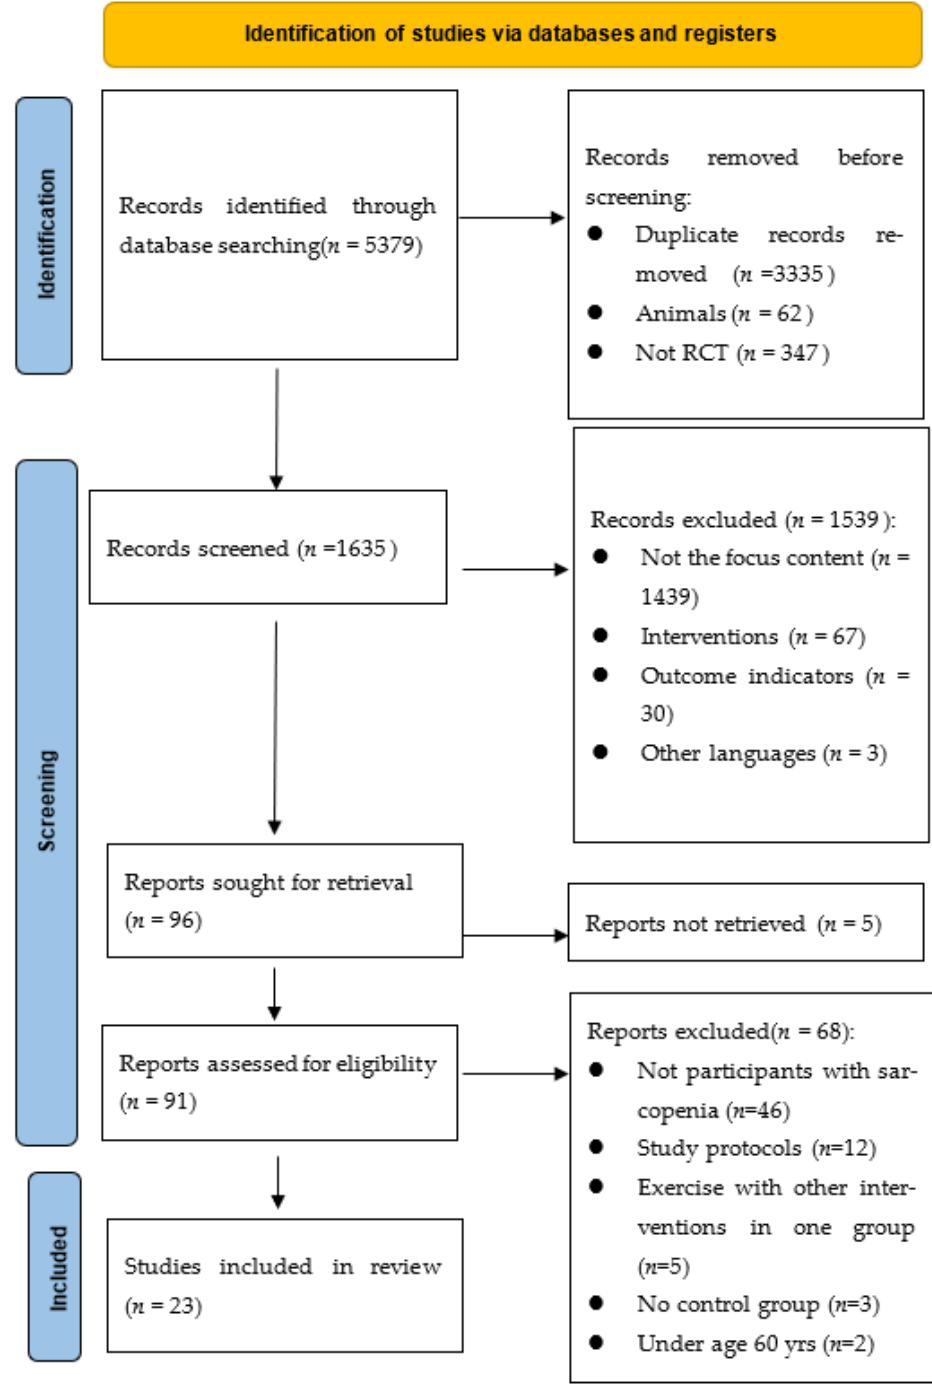
Figure 1. Flow diagram of the studies’ selection process.